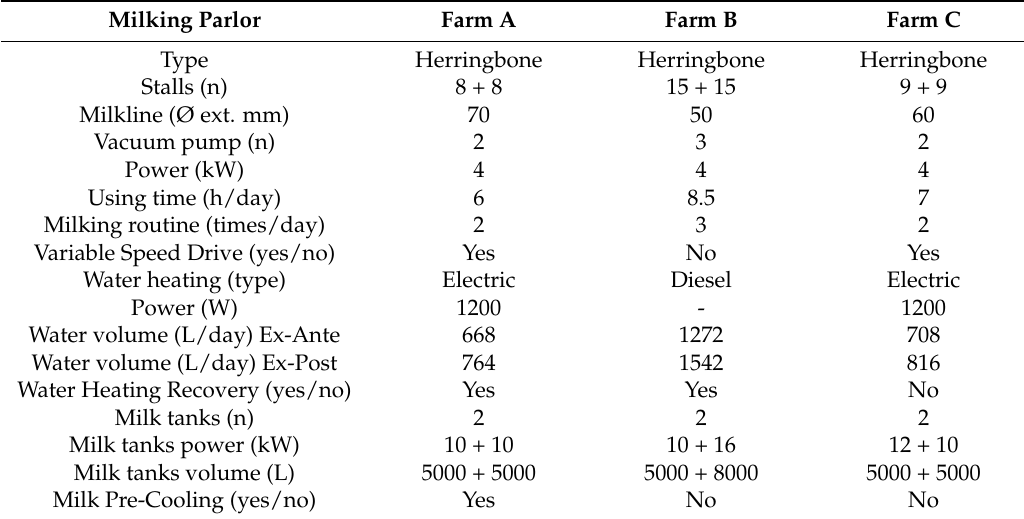
Table 1. Main characteristics and appliances found in the milking parlors of the three dairy farms involved in the study.